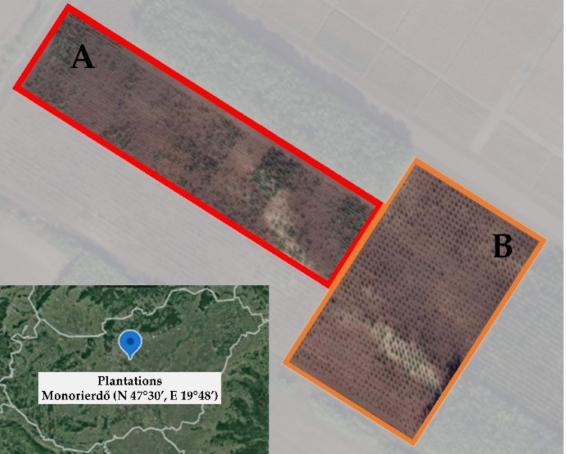
Figure 1. Study site of black locust ( A ) and poplar plantation ( B ) (https://earth.google.com/web/ @47.30475687,19.48656325,140.81392265a,1194.88813009d,35y,0.00005561h,0.1766107t,-0r, accessed on 29 August